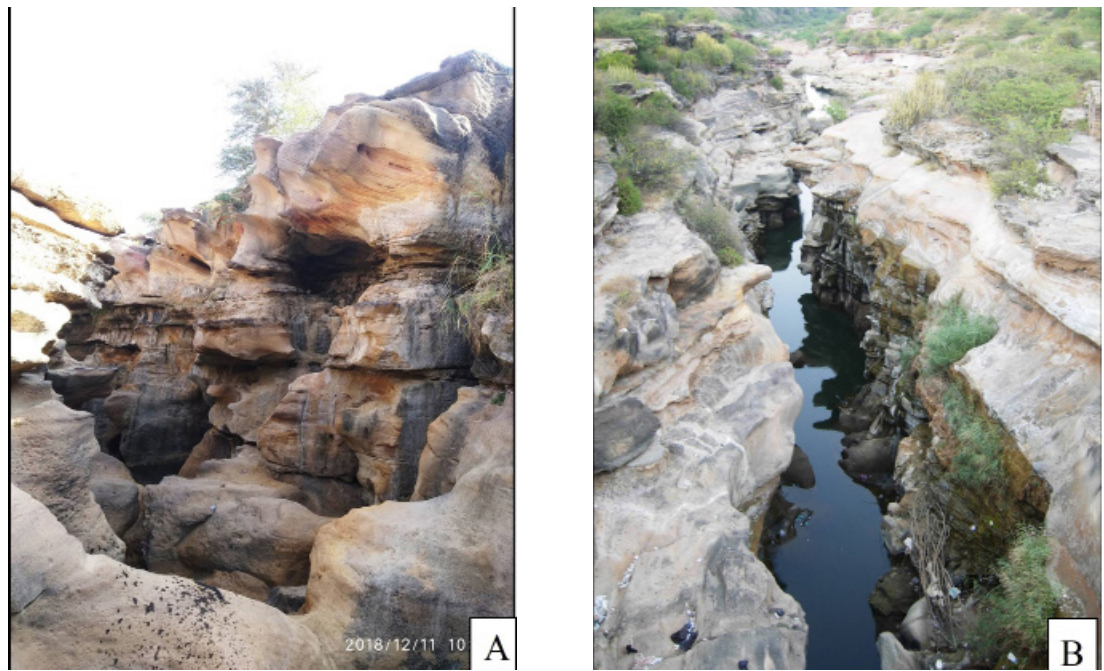
Figure 4. The Ler Dome. A) 6 m thick succession of nodular shale. B) The Dhosa Oolite Member (Oxfordian), a regional marker bed. C) Ferruginous sandstone dyke near road cutting, Ler village.